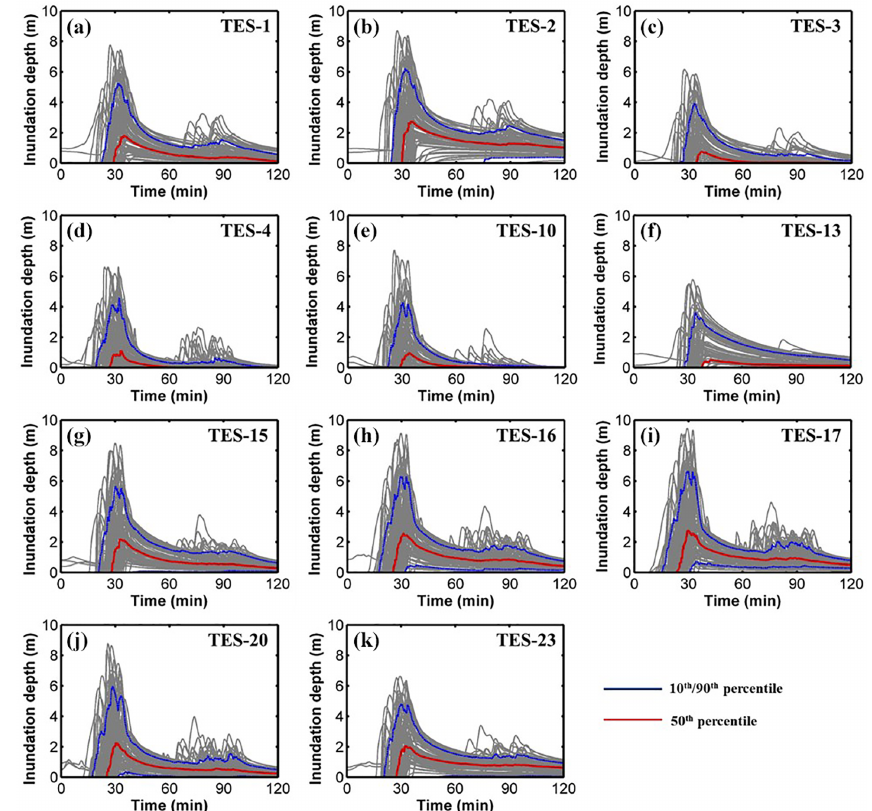
Figure 15. (a–k) Inundation depth variability at TES stations located near the coastal line and the rivers.